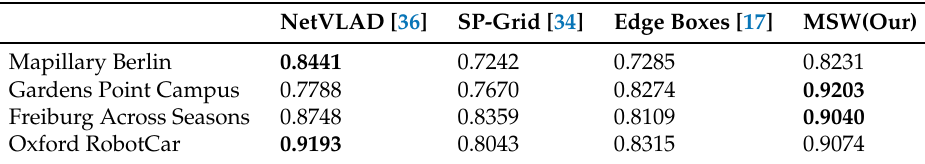
Table 2. Comparison of our method with the state-of-the-arts (AP).